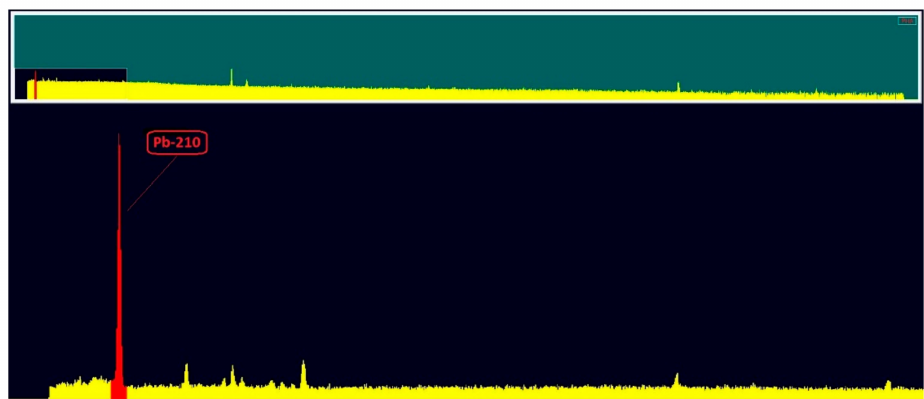
Figure 4. Typical γ spectrum of a wet and dry deposition sample: the 210 Pb 46.5 keV peak, marked in red, is well shaped and clearly